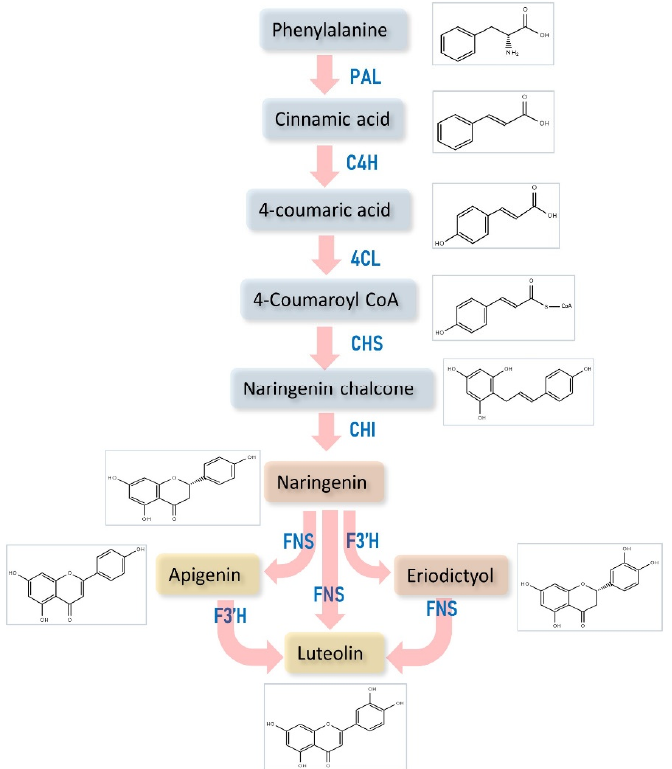
Figure 3. Diagrammatic representation of the biosynthesis of luteolin. PAL—phenylalanine am- monia lyase; C4H—cinnamate 4-hydroxylase; 4-CL—coumarate 4-ligase; CHS—chalcone synthase; F3 ′ H—flavonoid 3 ′ -hydroxylase; CHI—chalcone isomerase; FNS—flavone synthase.